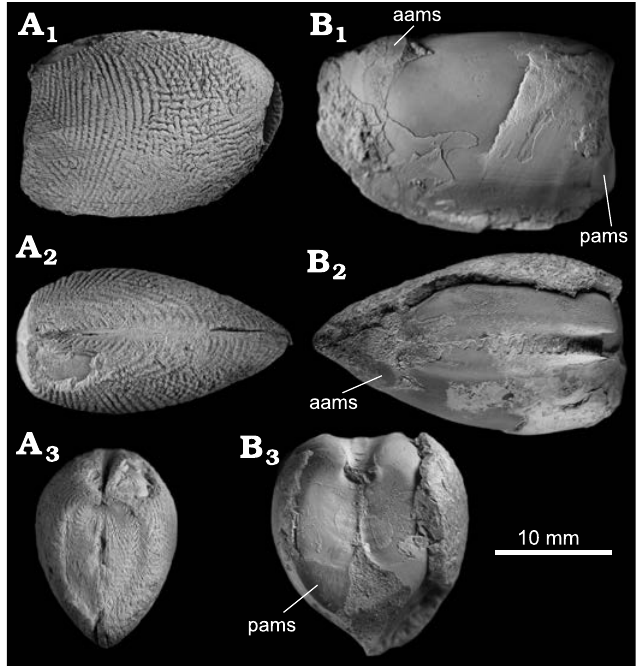
Fig. 3. The nuculid bivalve Acila ( Truncacila ) interferencia sp. nov. from Upper Miocene seep deposits of the Amlang Formation in Pangasinan province, Luzon, Philippines. A . NIGSPAL-004, holotype, an articulated specimen showing external sculpture; view on RV (A 1 ), dorsal view on an- terodorsal margin (A 2 ) and on posterior margin (A 3 ). B . NRM Mo 192694, paratype, specimen with most of the shell material removed, revealing internal features; view on LV (B 1 ), dorsal view on anterodorsal margin (B 2 ) and on posterior margin (B 3 ). Abbreviations: aams, anterior adductor muscle scar; pams, posterior adductor muscle